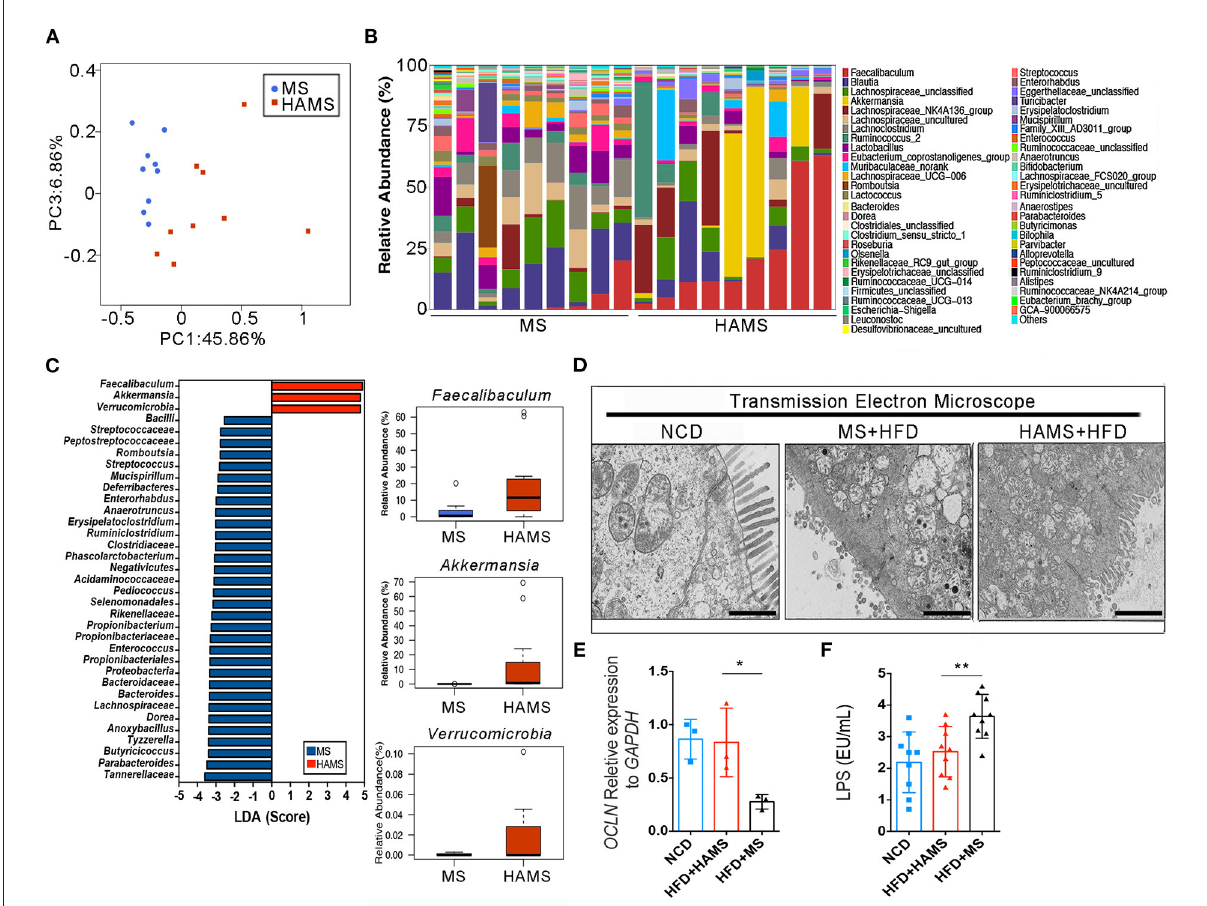
FIGURE4 Akkermansia was significantly enriched in the HAMS group. (A) PCoA of the gut microbiota ( n = 9 biologically independent HAMS animals vs. n = 9MS animals) from the HAMS group and MS group are shown. (B) Relative abundances of the gut microbiota ( n = 9 biologically independent HAMS animals vs. n = 9MS animals) from the HAMS group and MS group are shown. (C) Faecalibaculum , Akkermansia , and Verrucomicrobia were enriched in the HAMS group. (D) Representative electron microscopy images of freshly collected colon tissues from HAMS and MS mice. The bar represents 20 µ m. (E) Changes in the expression of OCLN were detected by qPCR ( n = 3 biologically independent HAMS animals vs. n = 3MS animals; the data are presented as the mean ± SEM, * P ≤ 0.05, Student’s t -test). (F) Serum LPS of the three groups of mice ( n = 9 biologically independent HAMS animals vs. n = 9MS animals; the data are presented as the median ± SEM, ** P < 0.01, one-way ANOVA with Bonferroni post hoc test. N = 9 NCD animals are also